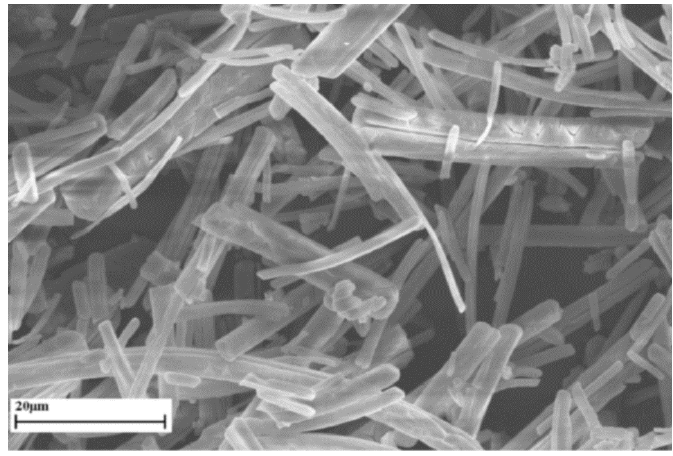
Figure 2. SEM micrograph of the precipitates obtained with the typical prismatic pattern characteristic of struvite crystals.